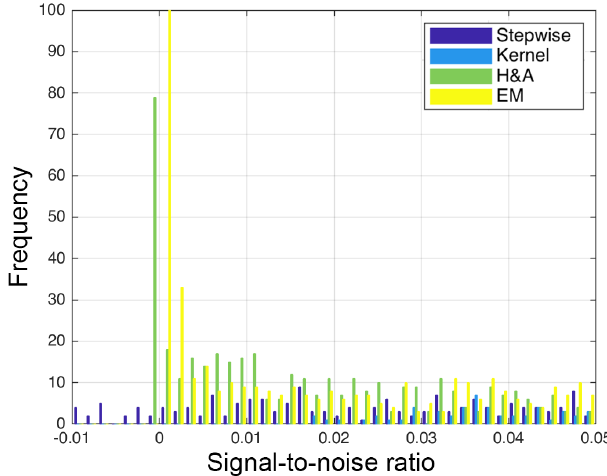
Figure 3. Signal-to-noise ratio of all selected study days. Data shown are the integrated concentrations from the whole size range with the total concentration measured at the cut-off of 2.8nm (0.1Lmin − 1